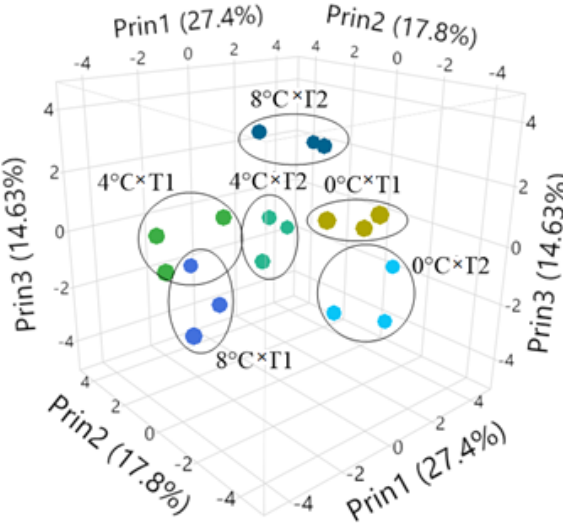
Figure 6. Three−dimensional scatter diagrams of the relationships among the storage temperature and pollination frequency interaction. (T1: 4-day intervals pollination, T2: 8-day intervals pollination; Prin1: Principal compenent 1, Prin2: Principal compenent 2, Prin3: Principal compenent 3.)